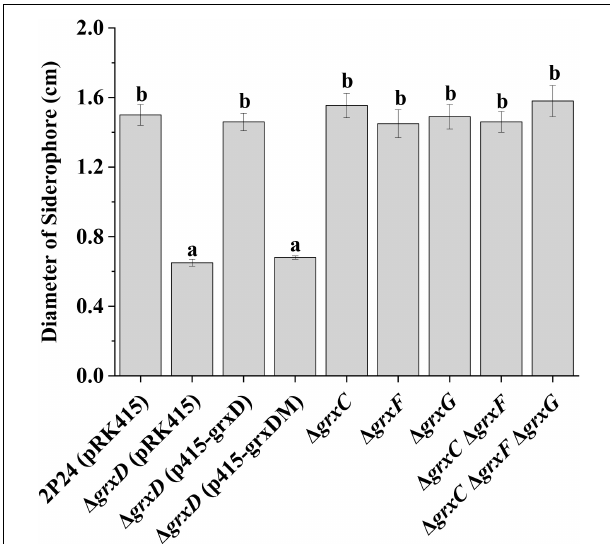
FIGURE 6 | Effects of grx mutants on siderophore production of Pseudomonas fluorescens . Siderophore production of strain 2P24 and its derivatives was indicated by the diameter of the orange circle on the chrome azurol S (CAS) plate. The experiment was performed in triplicate, and different letters indicate a significant difference at the 0.05 level.